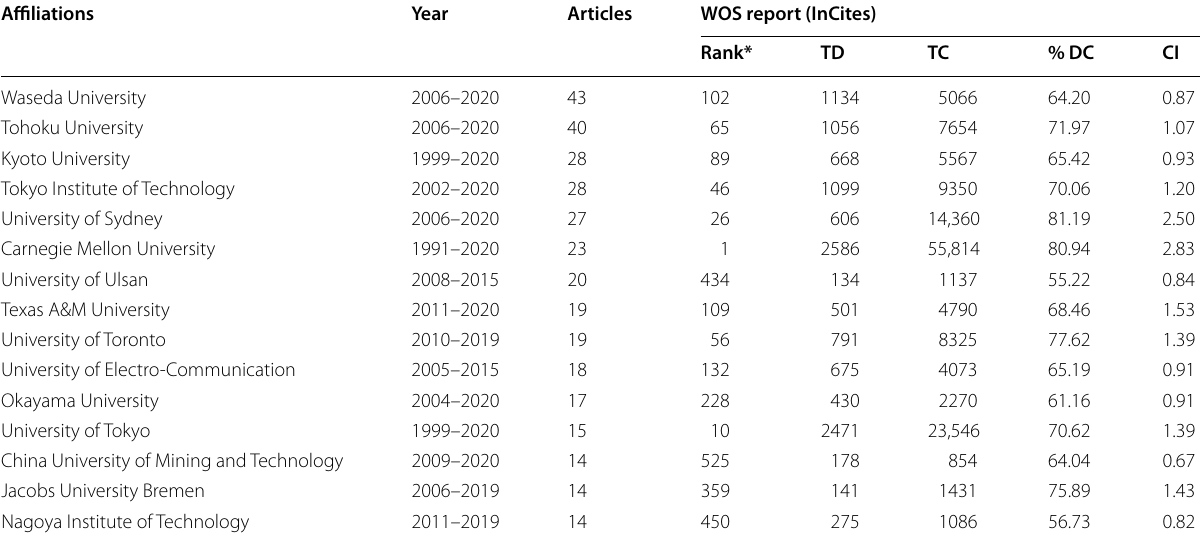
TD total WOS documents; TC total citation of WOS documents; % DC percent of WOS documents cited; CI citation